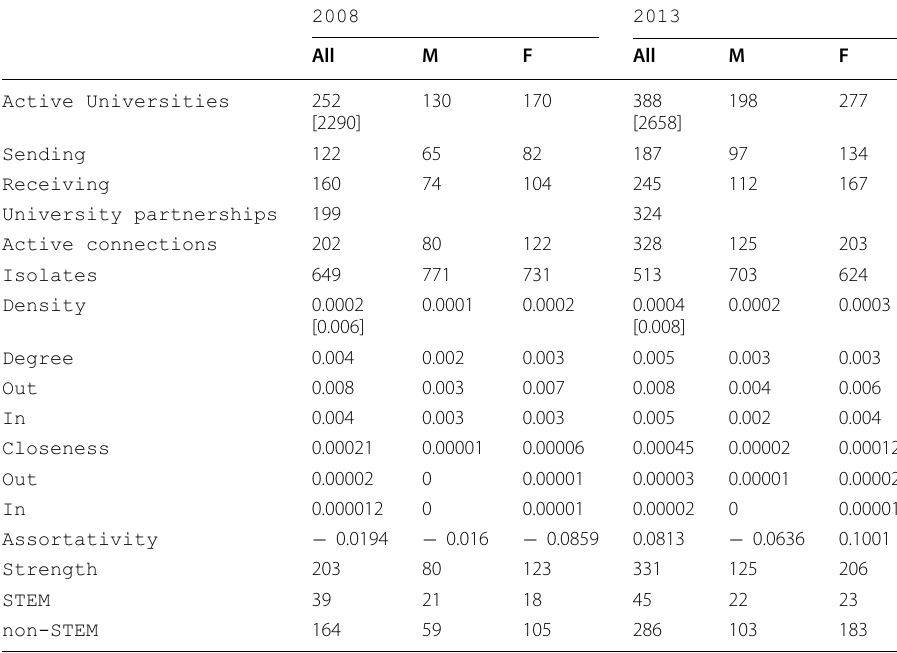
See Wasserman and Faust (1994) for the definition of the statistics used. M stands for male; F stands for female. Degree stands for Degree centralization (standardized); Closeness stands for Closeness centralization (standardized); Active connections includes student flows in different fields of study; the Assortativity score is [ − 1,1]. Values in squared brackets refer to the entire network of Erasmus student flows and are taken from (De Benedictis and Leoni